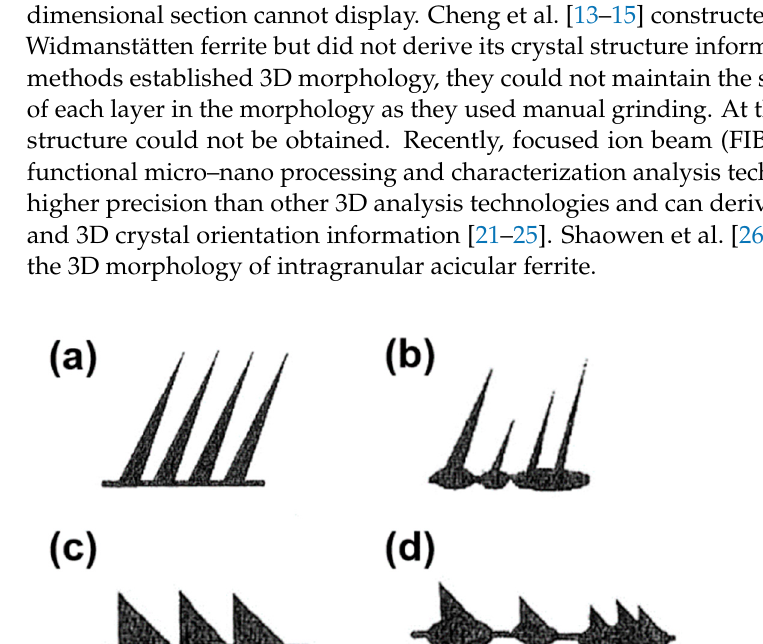
Table 1. Chemical composition of high-strength low-alloy steels (mass,